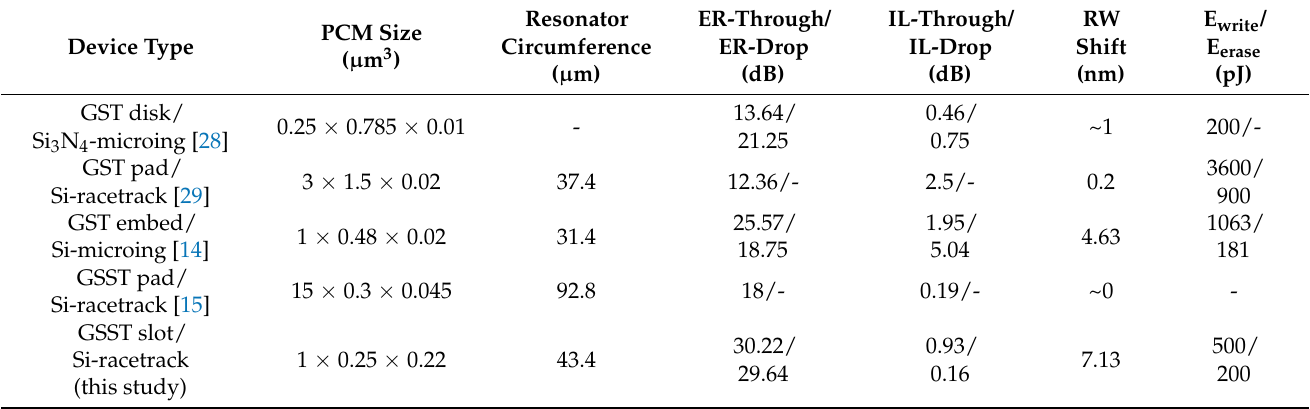
Table 2. Performance comparison of the phase-change devices based on microring